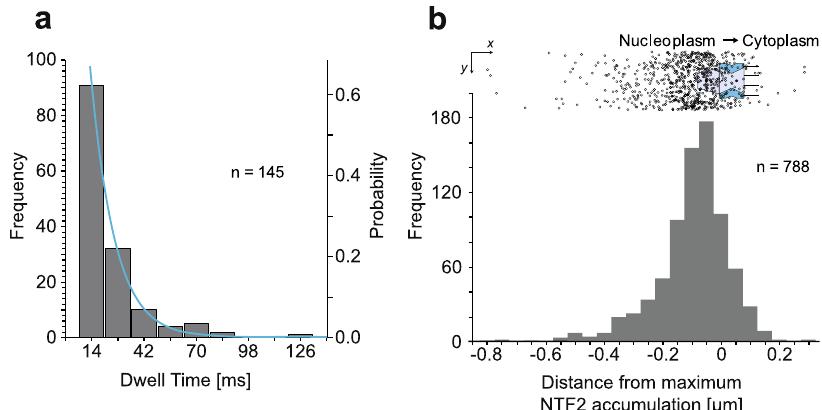
Fig. 5 Failed nuclear export of pre-60S particles. a The bar height indicates the frequency of the observation of the respective dwell times. The total number of evaluated trajectories was n = 145. The blue line indicates the best fi t using a single exponential decay function and yielded τ = 13 ± 3 ms. b (Top) The trajectories were aligned to the transporting NPC (as indicated by the maximum of the eGFP-NTF2 signal) as the origin and then rotated such that the export direction coincided with the positive x axis. (Bottom) The number of pre-60S particle positions in a y axis region ±100 nm off the central NPC was plotted as a function of the location with regard to the average NTF2 accumulation. The maximum clearly coincides with the nuclear basket. The total number of single positions shown is n =